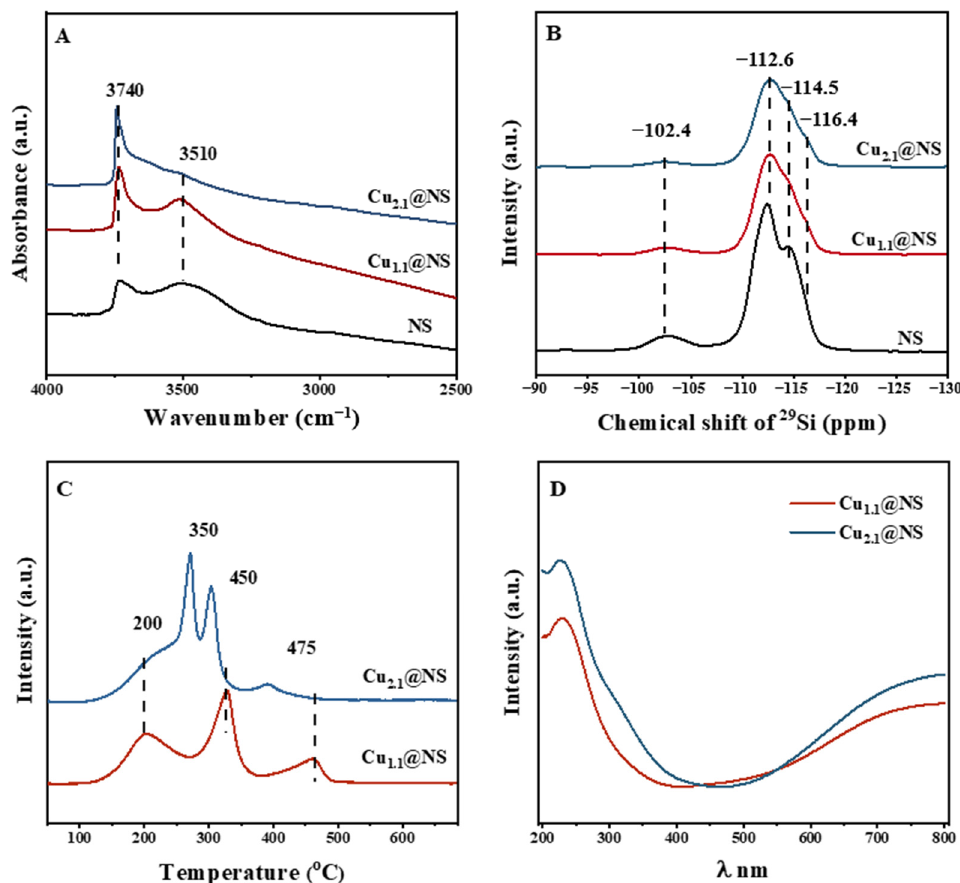
Figure 4. Characterization of Cu 1.1 @NS and Cu 2.1 @NS materials: ( A ) FTIR of dehydrated samples in the -OH vibration region; ( B ) 29 Si MAS NMR; ( C ) TPR curves of calcined samples in 2% H 2 /Ar